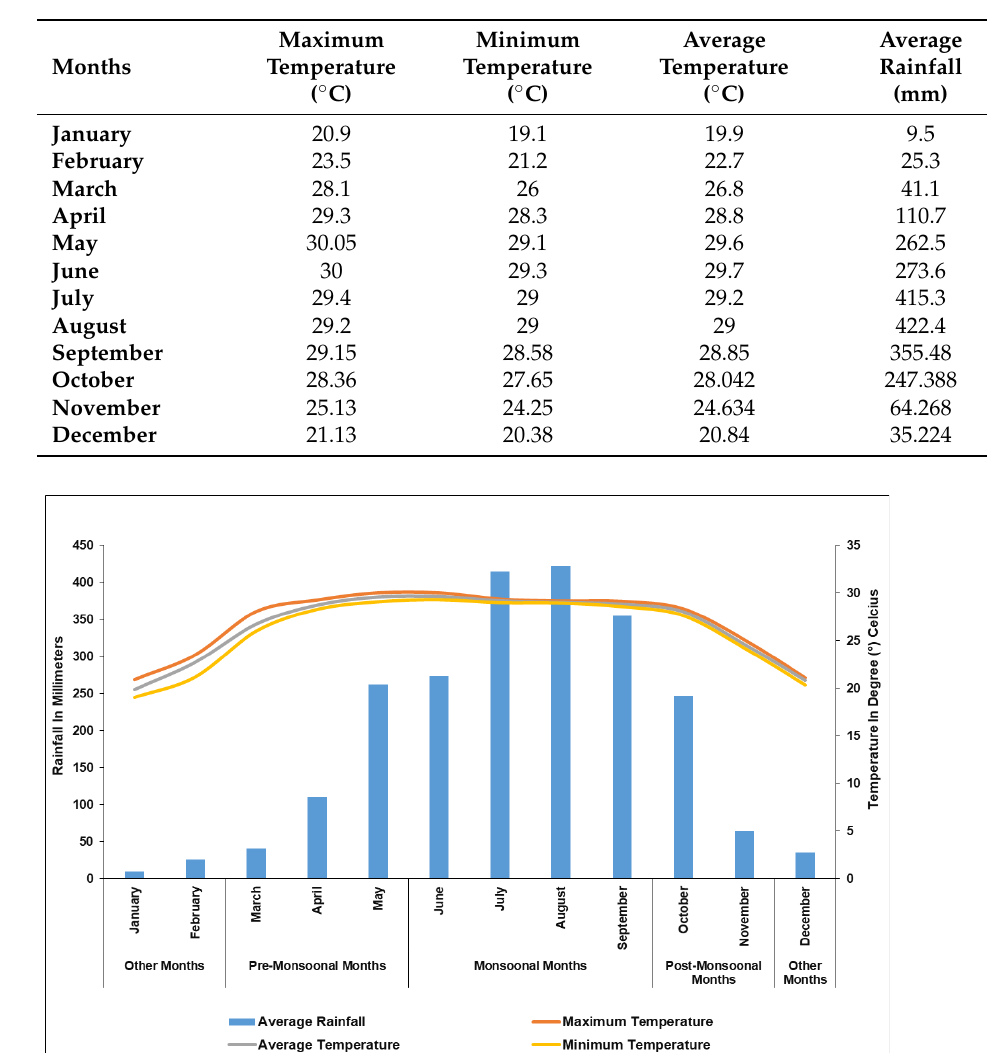
Figure A4. Monthly temperature and precipitation graph for the Subarnarekha River, area of Delta Sub-basin (2017 – 2021). Data Source: IMD.